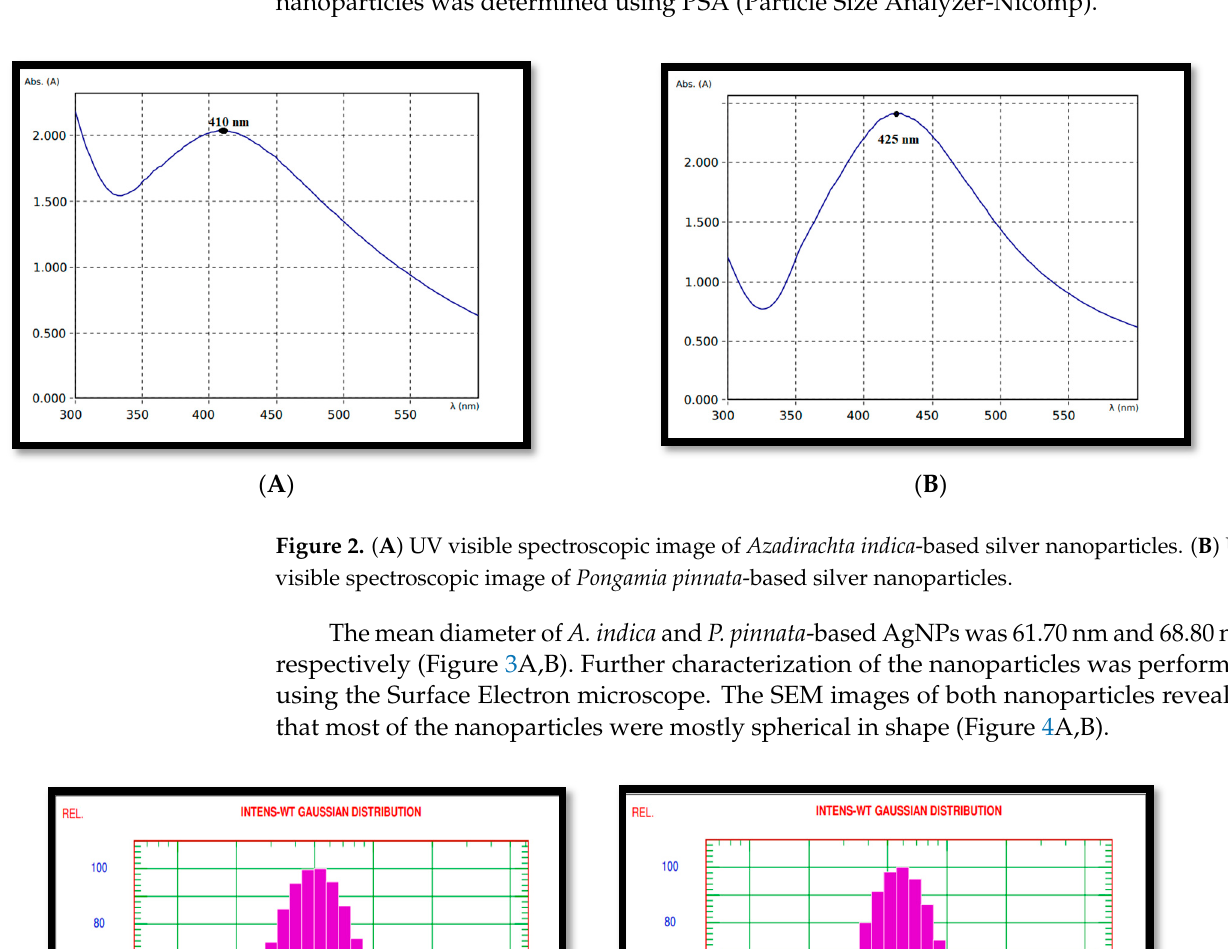
( B ) Figure 4. ( A ) SEM image of A. indica -based AgNPs at 61.70 nm. ( B ) SEM image of P. pinnata AgNPs at 68.80 nm. Table 1. Toxicity of green AgNPs. Synthesized from leaves of Azadirachta indica on larval mortality of H. armigera (Instar 2). Concentrations